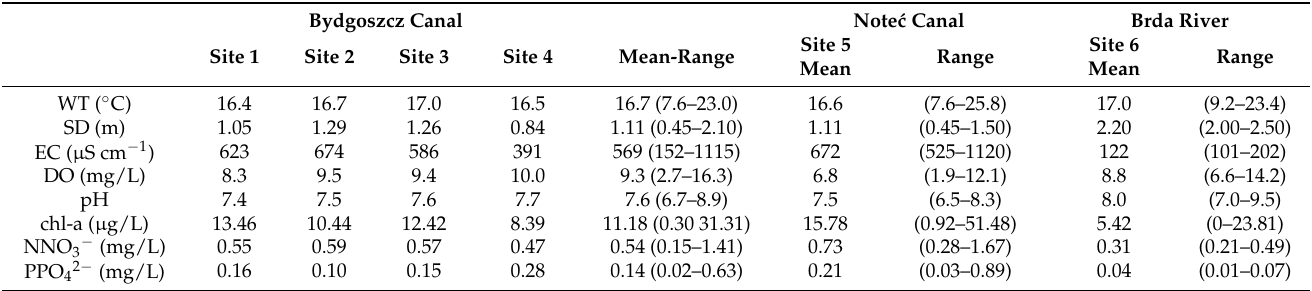
Table 1. Environmental data during the growing season 2019 in the Bydgoszcz Canal, the Note´c Canal, and the Brda River